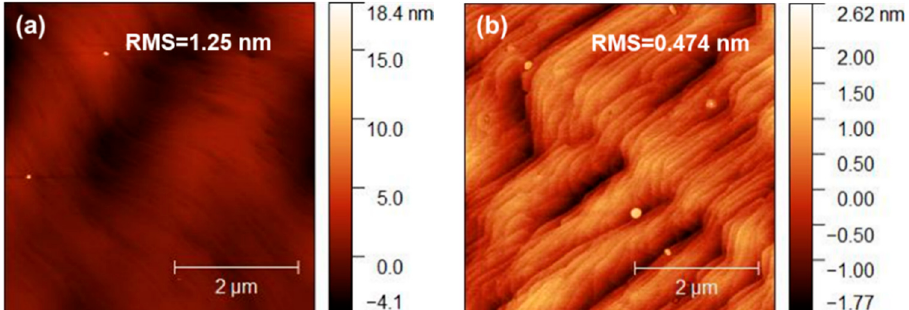
Figure 4. The 5 μ m × 5 μ m AFM images of ( a ) sample A and ( b ) sample B. Figure 4. The 5 µ m × 5 µ m AFM images of ( a ) sample A and ( b ) sample